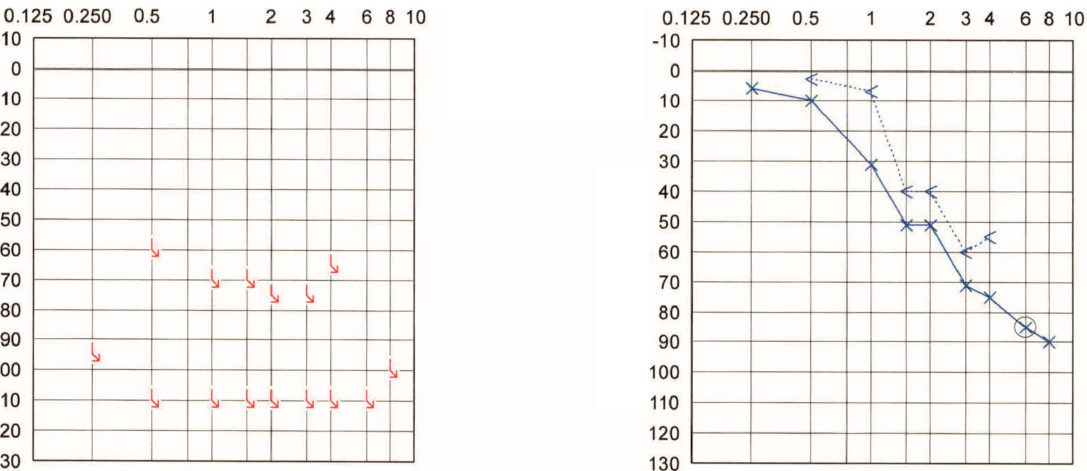
Figure 2. Pure tone audiogram of Patient #3 approximately 45 years after right-sided modified radical mastoidectomy with partial labyrinthectomy for extensive middle ear cholesteatoma.